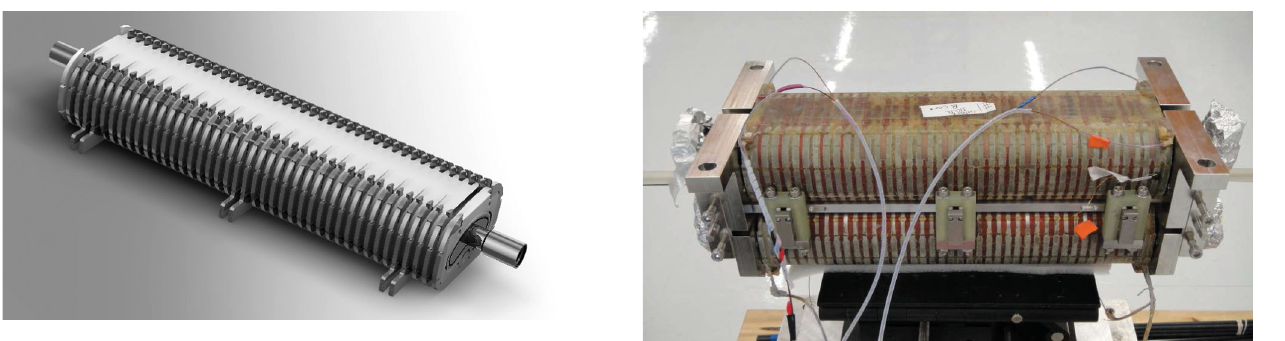
FIG. 3. Design model of the SCU0 core.